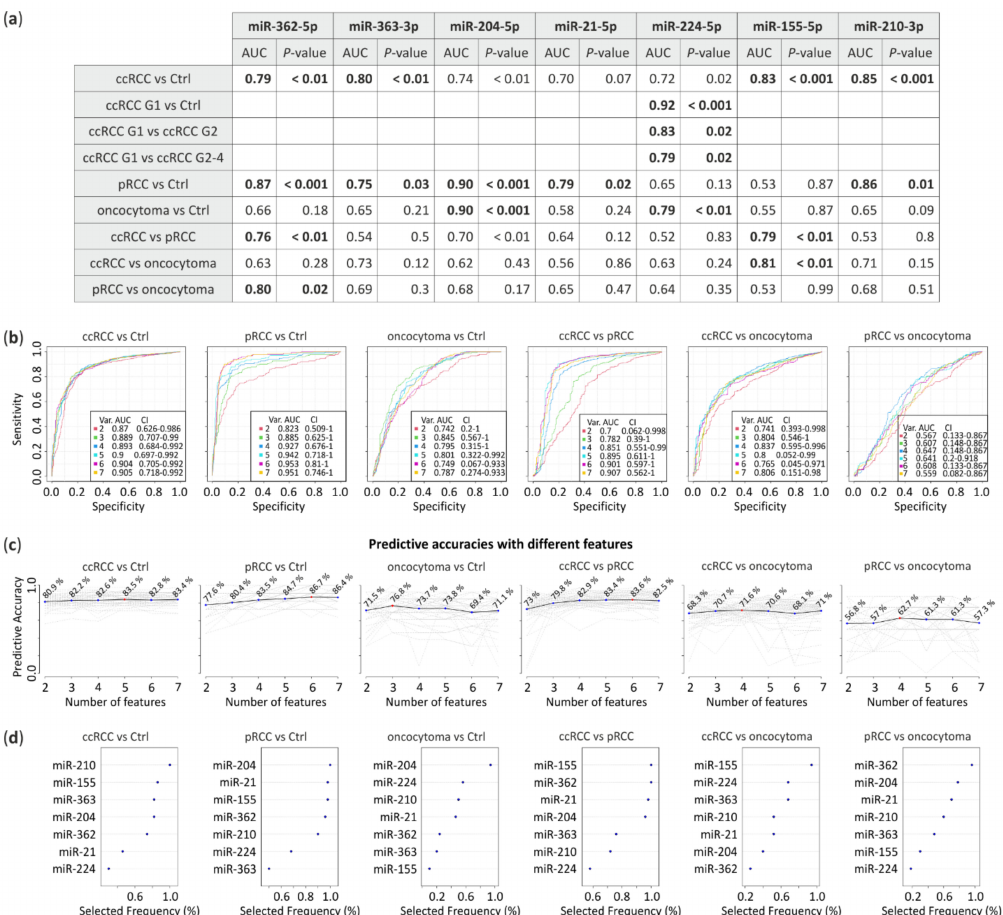
Figure 3. Receiver Operating Characteristic (ROC) analysis predictive potential of selected miRNA. ( a ) Area under the curve (AUC) with p -value calculated from miRNA expression level obtained from qPCR. Bold, comparisons with AUC > 0.75 and p -value < 0.05; ( b ) ROC multivariate analysis with seven proposed miRNAs; ( c ) Predictive accuracies with different miRNAs (red dot indicates a number of features with the highest predictive accuracy) and ( d ) frequency of selection in the